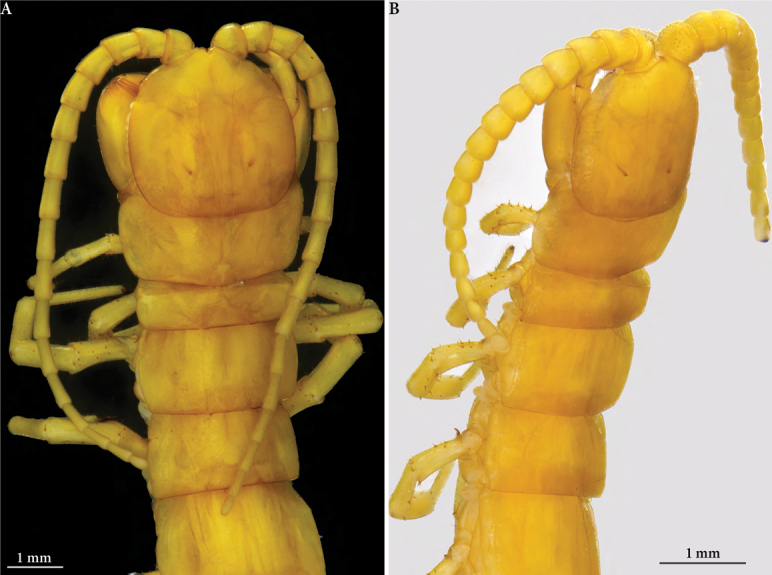
Cryptops spp., head and anteriormost segments ACryptops
speleorex sp. nov., holotype, dorsal view BCryptops
anomalans, Pirin Mts (Bulgaria), dorsolateral view (slightly apical).